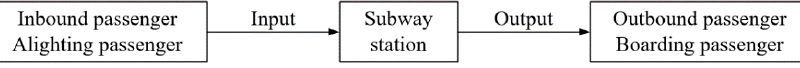
Figure 2. Service system at the station.